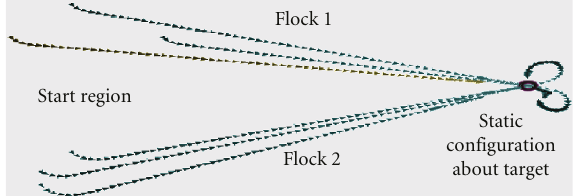
Figure 11: Six agents flocking to the target using the superposition action selection scheme.